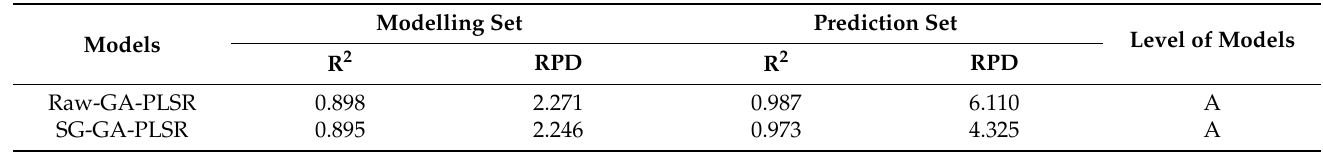
Table 3. Modelling prediction results of the content of calcium in pear pulp based on the selected characteristic wavelengths by using GA.